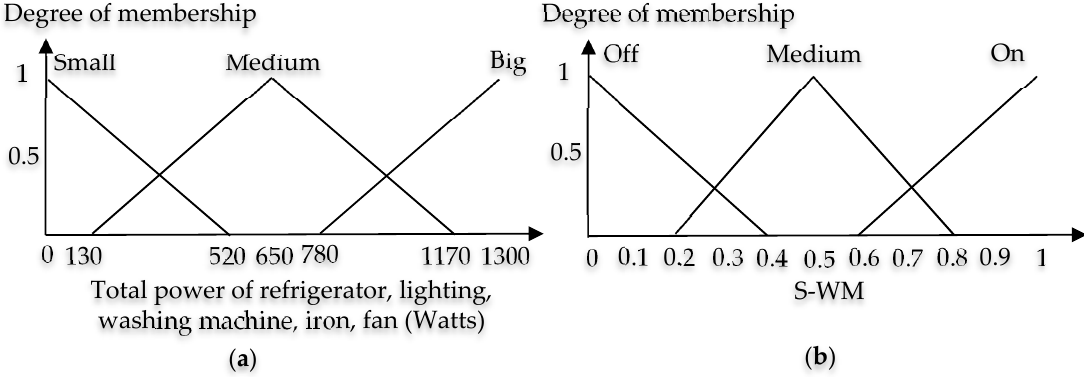
Figure 4. ( a ) Membership function of the total power of the refrigerator, lighting, washing machine, iron, fan; ( b ) membership function of the S-WM.